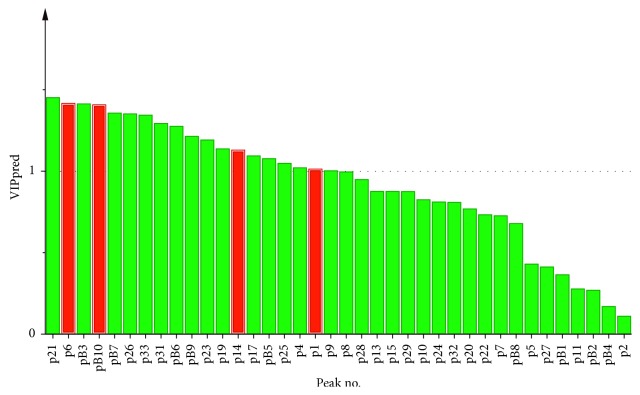
The plot of VIP.